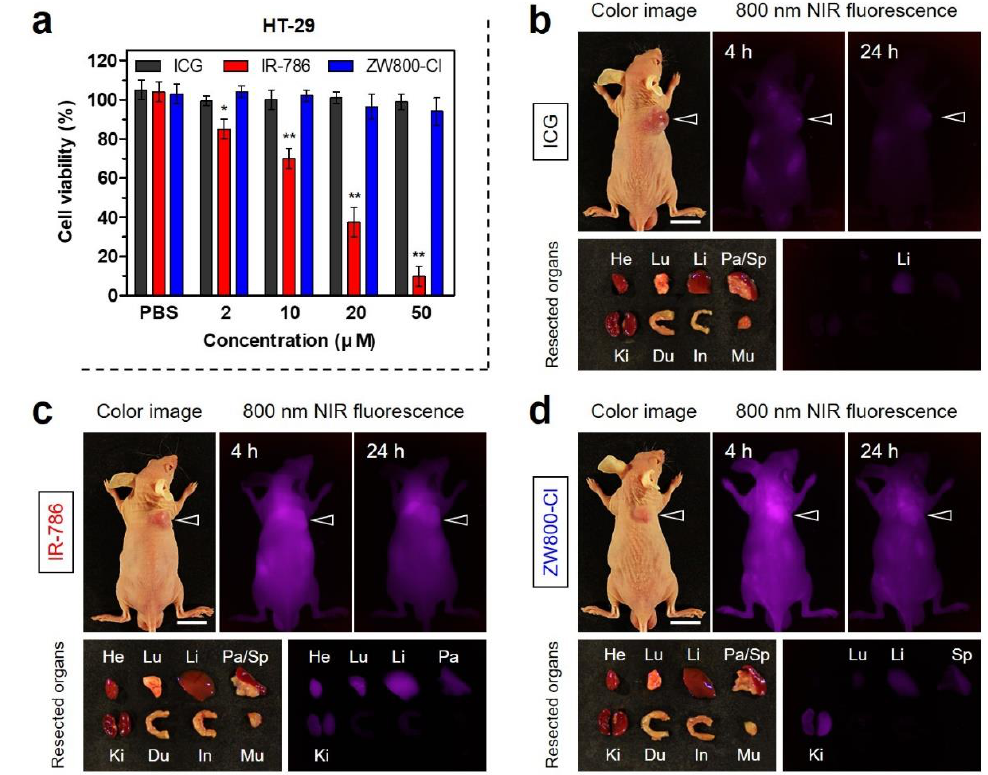
Figure 4. ( a ) Cell viability assay of each NIR dye using HT-29 cancer cells. The percentage cytotoxicity was determined after 24 h of treatment with various concentrations of each NIR dye. Data are expressed as mean ± S.D. ( n = 3, * p < 0.05; ** p < 0.01). In vivo HT-29 tumor targeting efficiency and biodistribution of ( b ) ICG, ( c ) IR-786, and ( d ) ZW800-Cl. The tumor site and resected major organs were imaged 24 h after injection of each NIR dye, respectively. The tumor sites are indicated by arrowheads. Abbreviations: Du, duodenum; He, heart; In, intestines; Ki, kidneys; Li, liver; Lu, lungs; Mu, muscle; Pa, pancreas; Sp, spleen. Scale bars = 1 cm. Images are representative of 3 mice per treatment group. All NIR fluorescence images had identical exposure times and normalization.